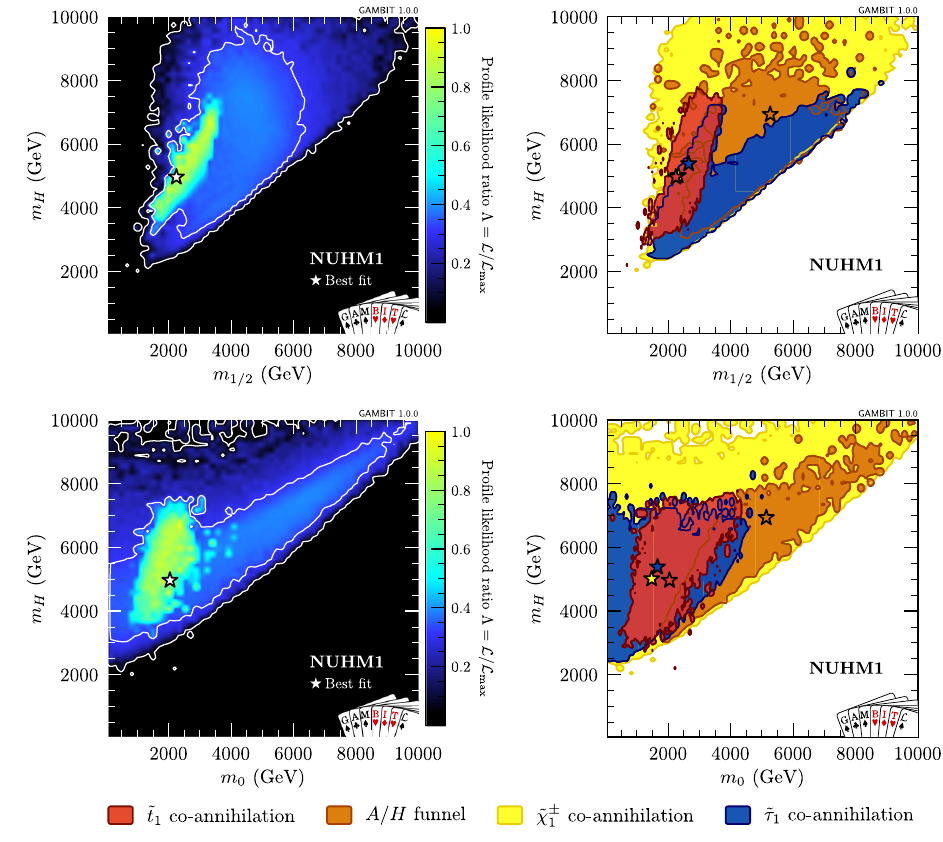
Fig. 6 As per Fig. 5, but for the m 1 / 2 – m H (top) and m 0 – m H (bottom) planes